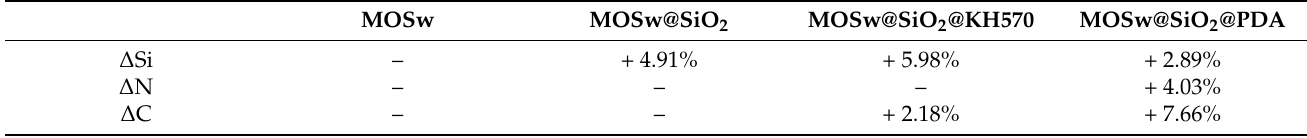
Table 1. Changes in the elemental content of whisker before and after